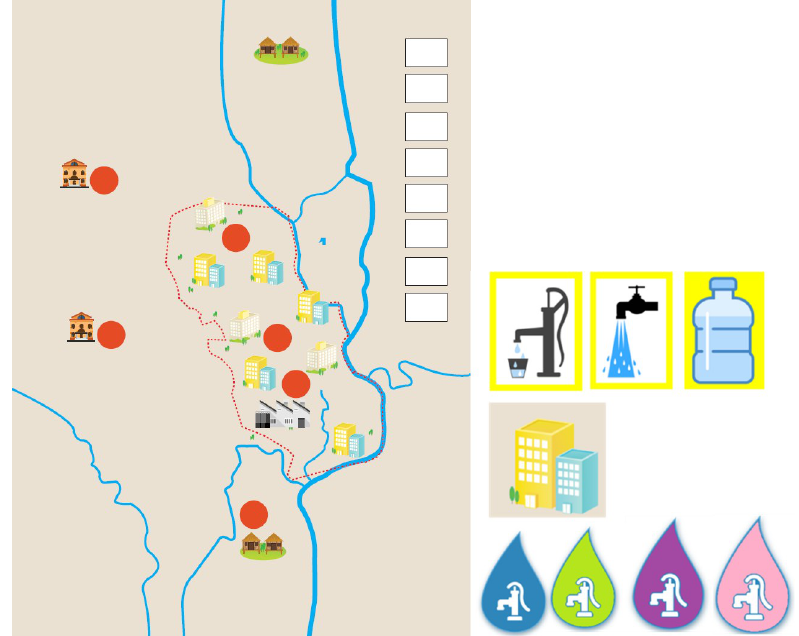
Figure 1. Game board (left); Game board pieces: (top row) drinking water icons, (middle row) city icons, (bottom row) groundwater monitoring icons.